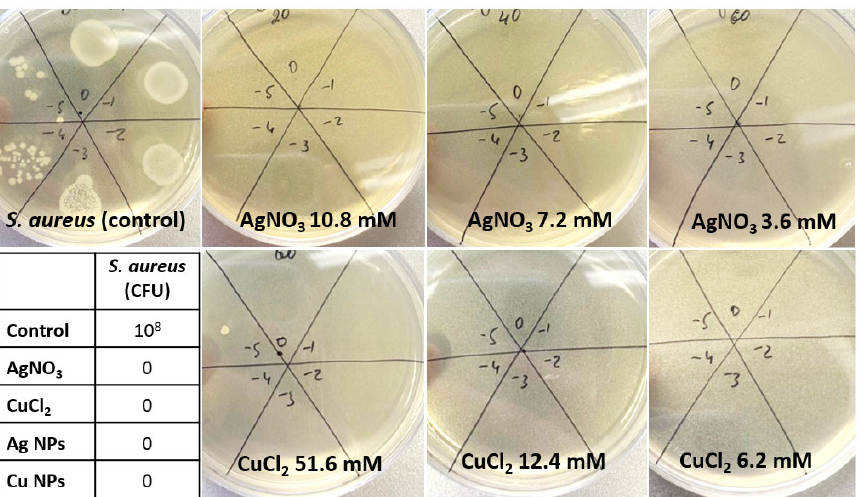
Figure A1. Photograph of S. aureus culture, treated with AgNO 3 and CuCl 2 solutions with different concentrations and the corresponding table with number of CFU after treatment. Data in the table represent the results for all used